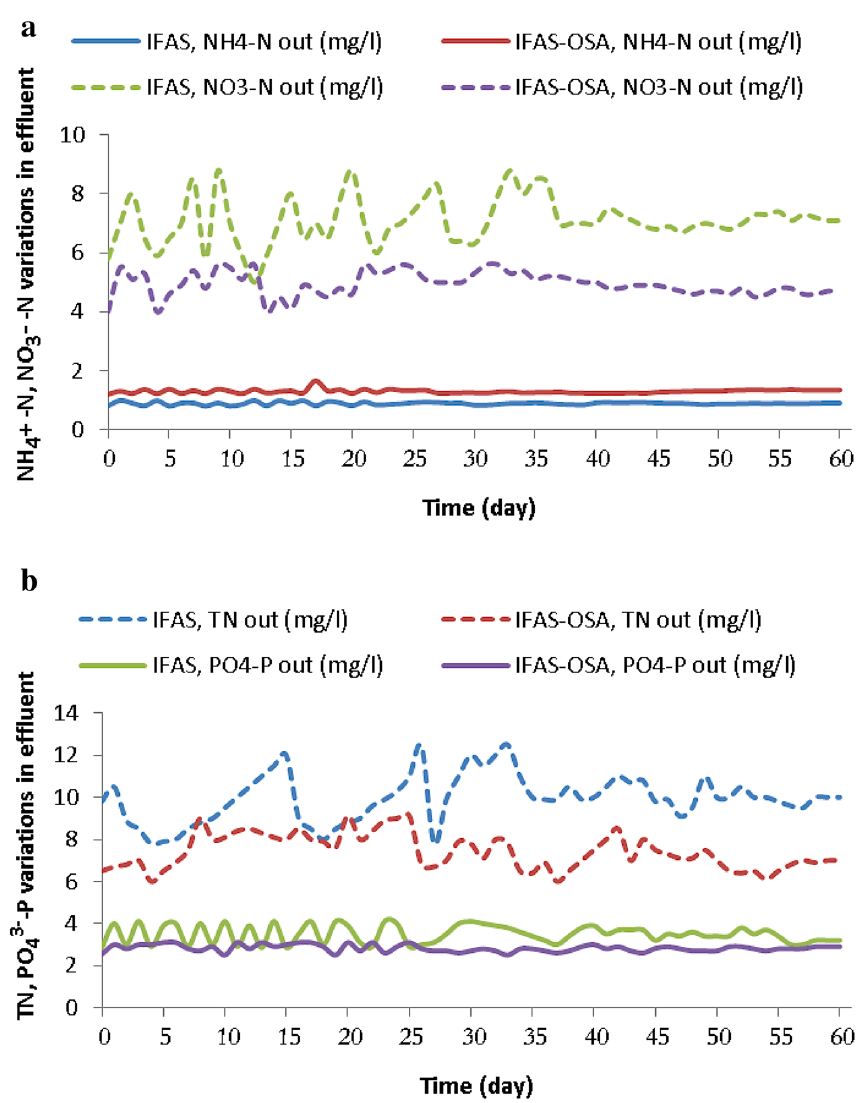
Figure 2. ( a , b ) Concentration variations of NH 4+ -N, NO 3 -N; b: TN, and PO 4–3 -P in the effluents of the IFAS and IFAS-OSA systems during the operation